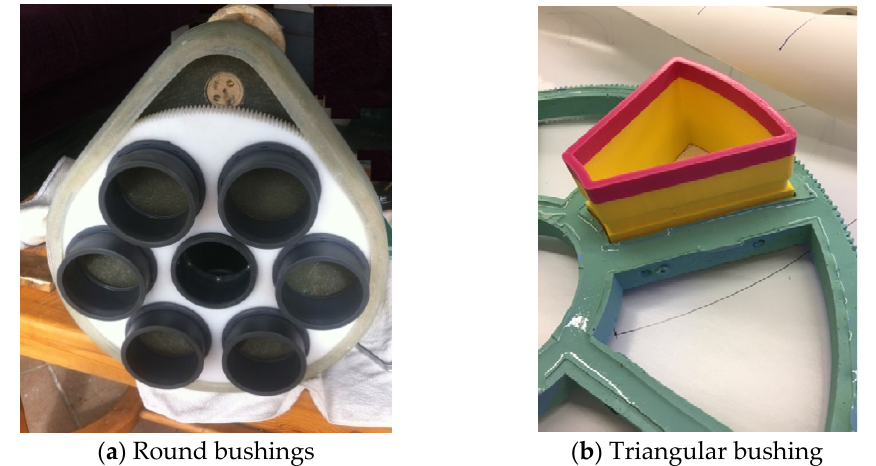
Figure 4. Plate designs, with round ( a ) and triangular ( b ) bushing.